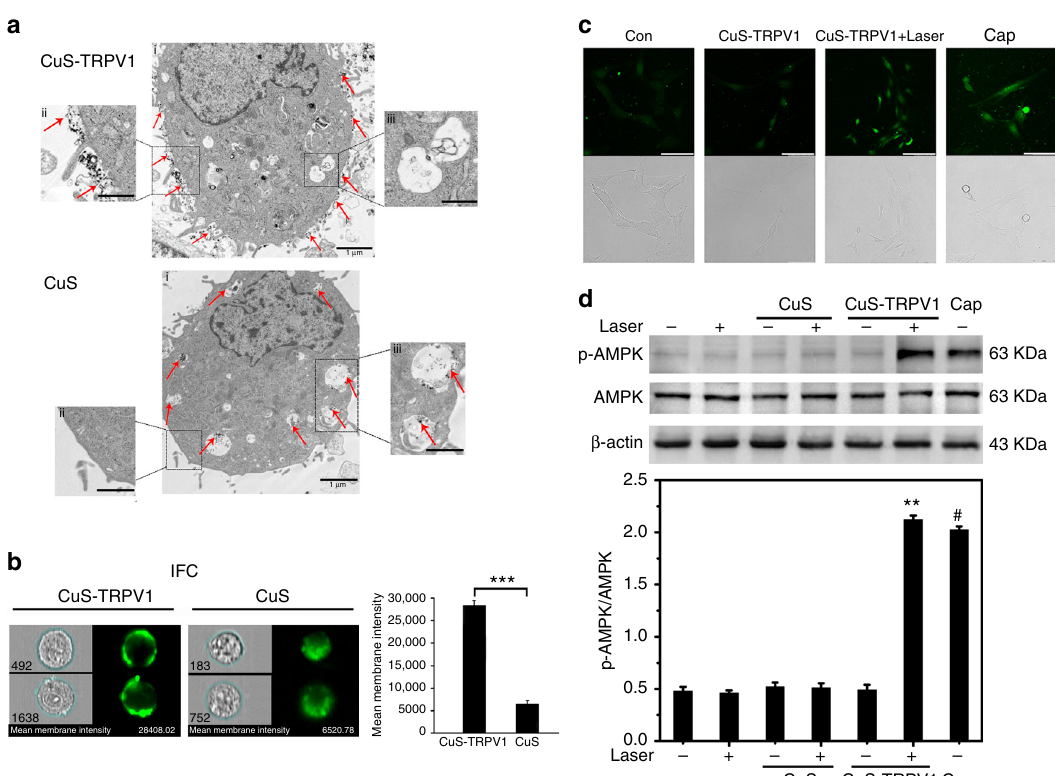
Fig. 3 Targeting of CuS-TRPV1 to VSMCs membrane and opening of TRPV1 channels. a Representative TEM images of VSMCs incubated with 0.4 mg mL − 1 of CuS-TRPV1 or CuS for 2 h. Red arrows indicated localization of NPs in (i) whole cell section under low magni fi cation, (ii) partially magni fi ed cell membrane and (iii) magni fi ed endosome or lysosome. Images are representative of three independent wells per group. Scale bar = 1 μ m. b Representative IFC images of VSMCs incubated with the fl uorescein-conjugated CuS-TRPV1 or CuS (0.4 mg mL − 1 ) for 2 h. Green fl uorescence in the blue area indicated NPs targeting to the cell membrane. Mean membrane intensity of CuS (blue area: 6,520.78) was 23% of CuS-TRPV1 (blue area: 28,408.02). Data are shown as mean ± S.D. of three independent experiments, and analyzed by Student ’ s t -test. *** P < 0.001. c Fluorescence imaging of Ca 2+ in fl ux in VSMCs induced by CuS-TRPV1 heating. VSMCs were incubated with 0.4 mg mL − 1 of CuS-TRPV1 and irradiated by the 980 nm laser (5 W/cm 2 ) for 1 cycle. Capsaicin (1 μ M) was used as a positive control. Images represent three independent wells per group. Scale bar = 50 μ m. d Western blot analysis of AMPK phosphorylation in VSMCs induced by CuS-TRPV1 heating-evoked Ca 2+ in fl ux. VSMCs were incubated with 0.4 mg mL − 1 CuS-TRPV1 and irradiated by the 980 nm laser (5 W cm − 1 ) for 10 cycles. Capsaicin (Cap, 1 μ M) was used as a positive control and CuS (0.4 mg mL − 1 ) was used as a negative control. The relative levels of AMPK phosphorylation were normalized to total AMPK, with β -actin serving as a loading control. Data are shown as mean ± S.D. of three independent experiments, and analyzed by Student ’ s t -test. ** P < 0.01 for CuS-TRPV1 +Laser vs. untreated group. # P < 0.05 for Cap vs. untreated